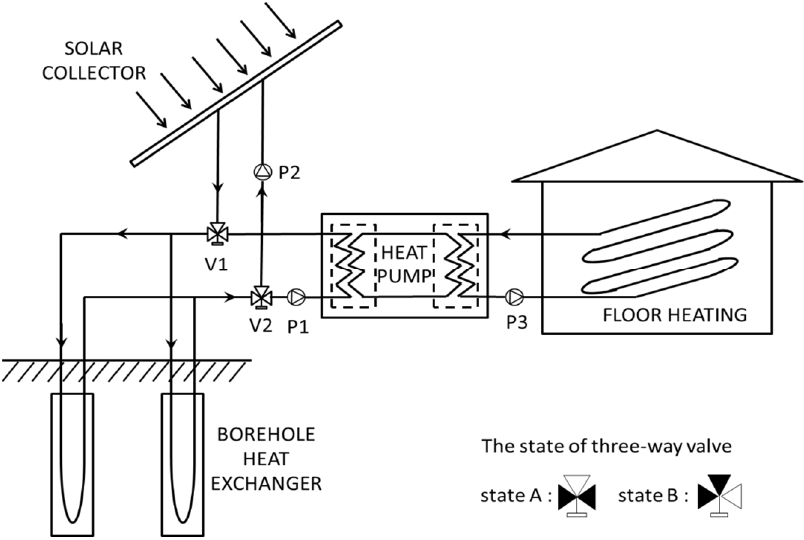
Figure 1. Conceptual diagram of the solar ‐ assisted ground heat pump system (SAGHPS).